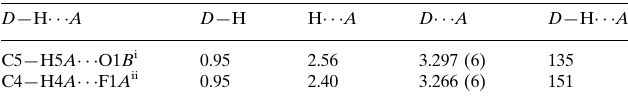
Hydrogen-bond geometry (A˚ , (cid:1)